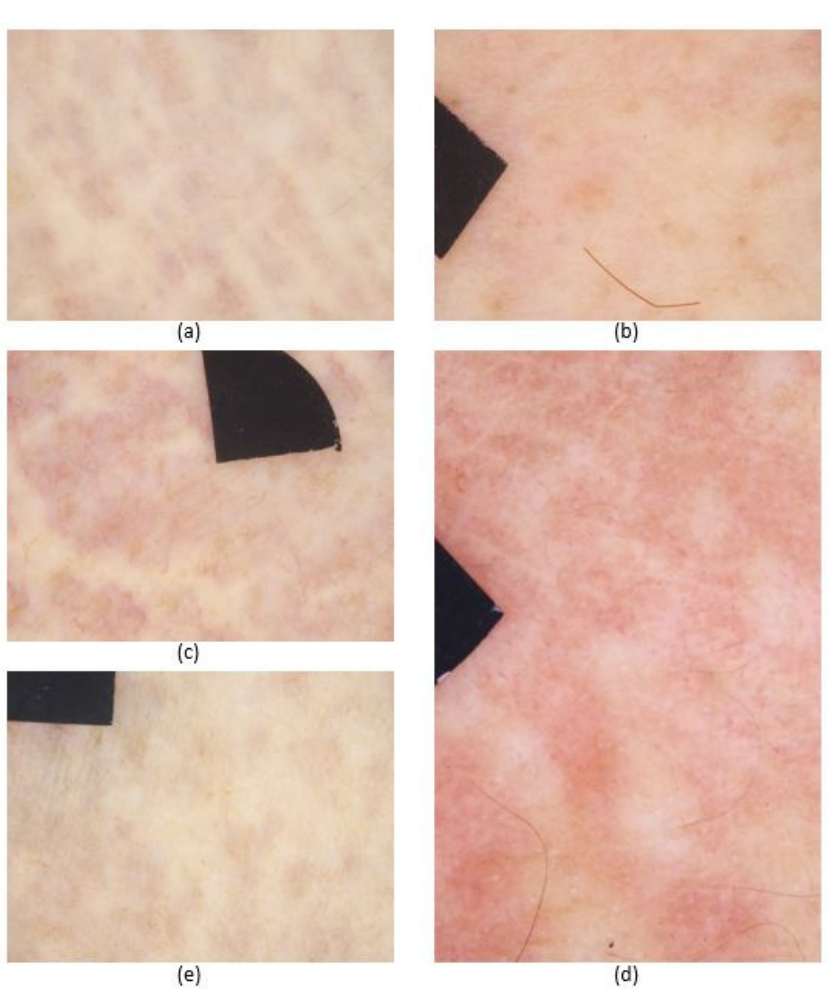
Figure 3. Representative dermoscopic images of the skin lesions of the patients with pseudoxanthoma elasticum. ( a ) Patient 1, linear pattern on the cubital fossa. ( b ) Patient 2, dots on the neck. ( c ) Patient 3, narrow mesh network on the axilla. ( d ) Patient 4, broad mesh network on the neck. ( e ) Patient 5, plaques of confluent dots and linear patterns in the antecubital fossa. Black markers do not point to areas of interest, they are used for image alignment (area: 0.125 cm 2 ).